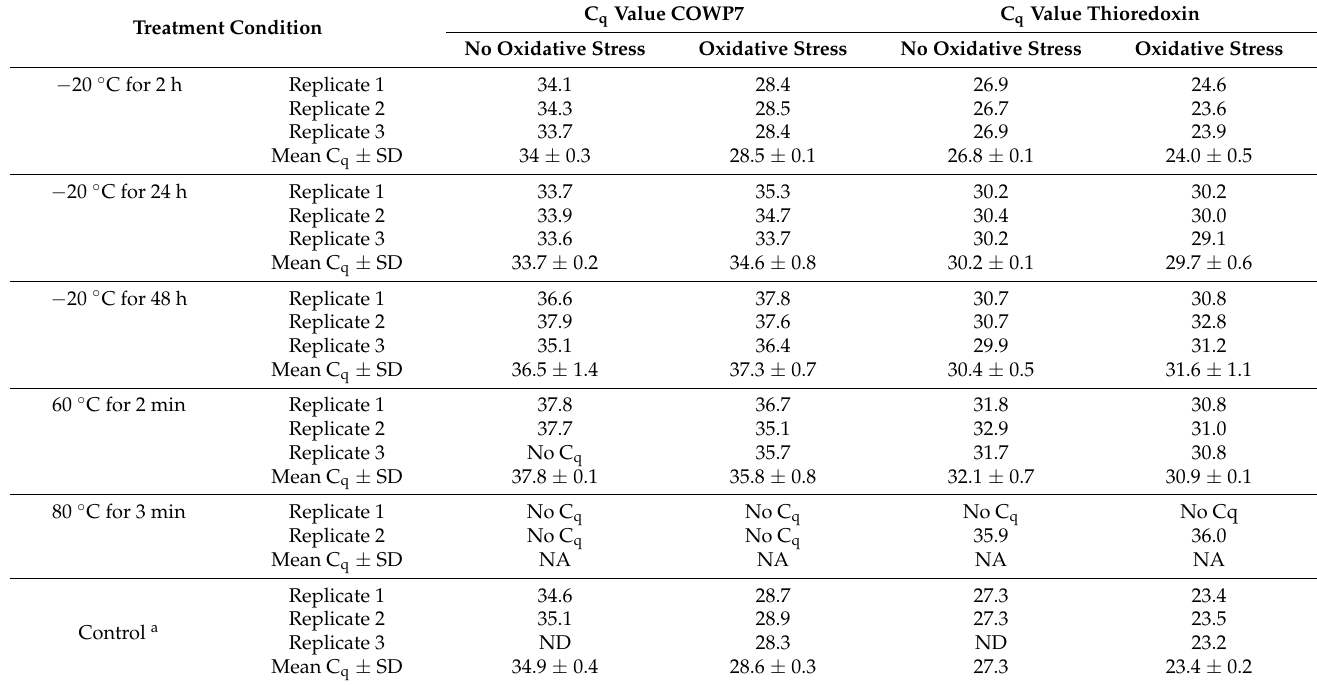
Table 5. The effect of extreme temperature on the viability of Cryptosporidium